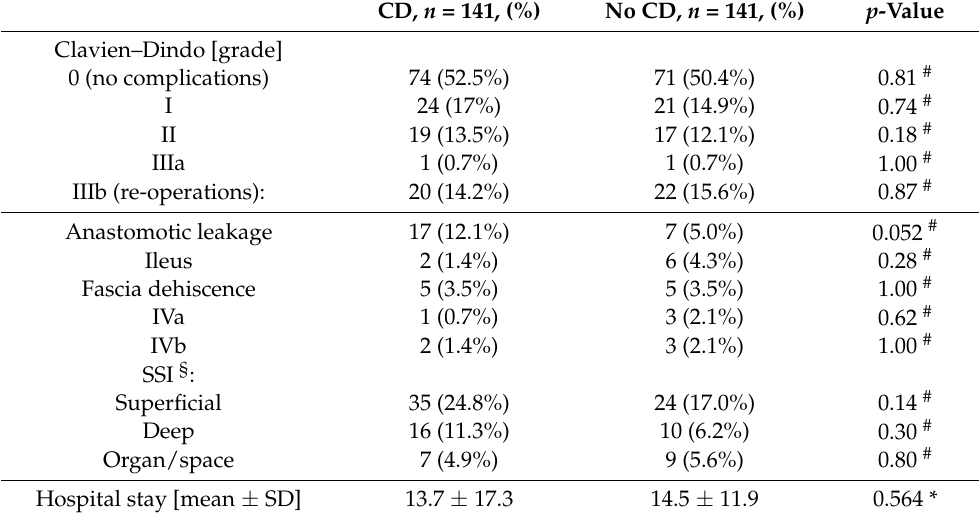
(Table 3). The reasons for re-operations were anastomotic leakage (17 CD vs. 7 control), small bowel perforation (0 vs. 1), ileus (2 vs. 6), bleeding (1 vs. 1), fascial dehiscence (5 vs. 6), surgi- cal wound-revision (4 vs. 2), planned 2nd-look laparotomy (0 vs. 2), or unclear abdominal pain (2 vs. 0) (re-operations according to Clavien–Dindo-type IIIb; patients can have more than one reason for a re-operation). Anastomotic leakage occurred in 17 patients (12.1%) in CD vs. 7 patients (4.4%) in the controls. Among these, there were entero-cutaneous fistulas (3 in the CD group and 1 in the control group). Table 3. Surgical outcomes and